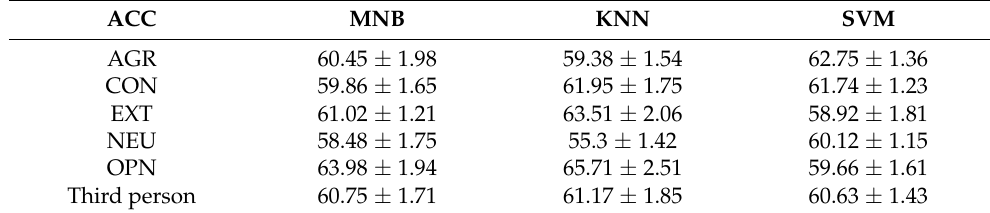
Table 2. Accuracy of the dataset in